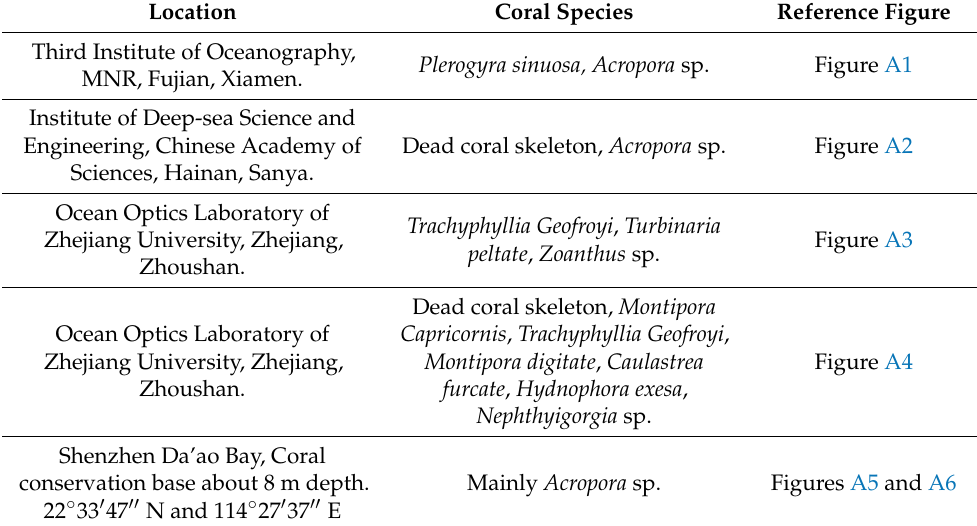
Table 1. Dataset collection for coral semantic segmentation.